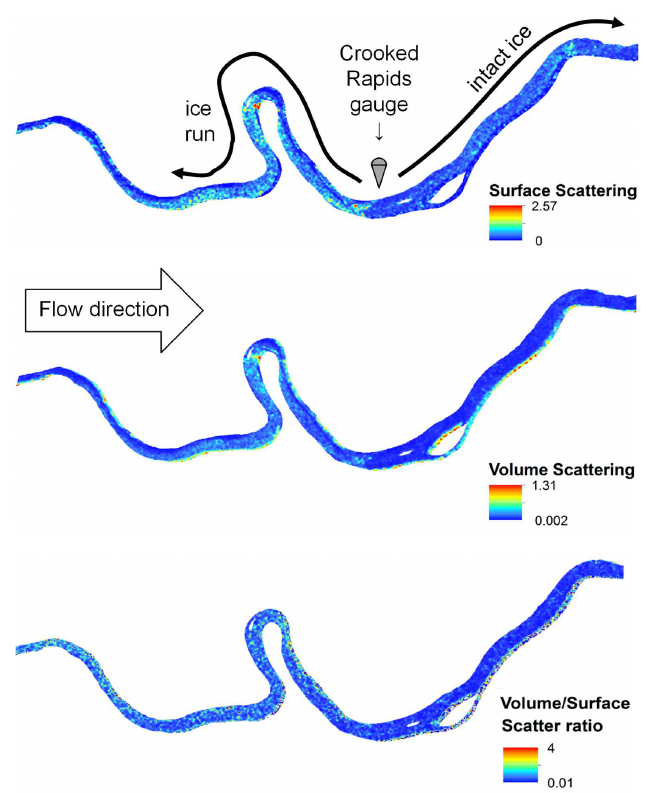
Figure 10. Surface scatter (top panel), volume scatter (middle panel) and volume scatter/surface scatter ratio (bottom panel) (RADARSAT-2 Data and Products © MacDonald, Dettwiler and Associates Ltd—All Rights Reserved. RADARSAT is an official trademark of the Canadian Space Agency).